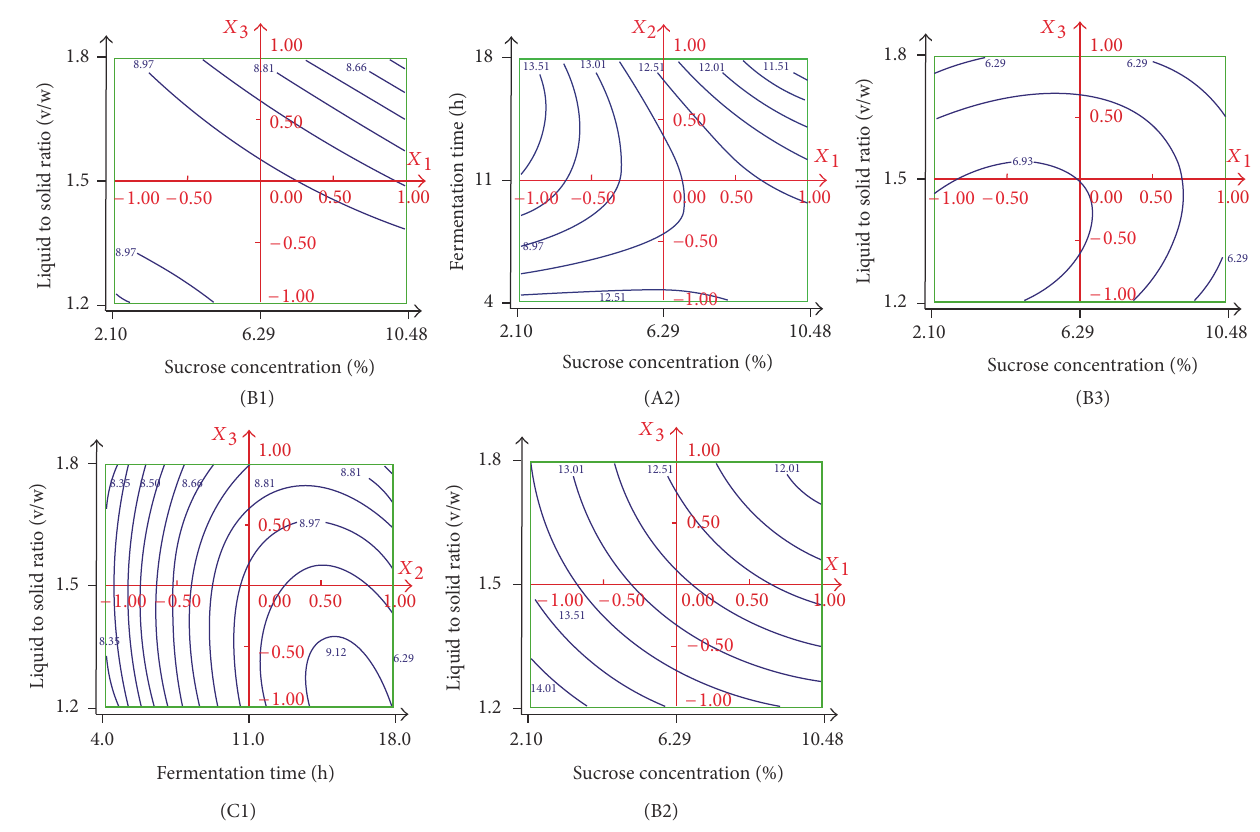
Figure 2: Responsesurface and contour plots that represent the effect of fermentation time and sucroseconcentration (A); liquid to solid ratio and sucrose concentration (B); liquid to solid ratio and fermentation time (C) and their interaction on ( 1 ) viable Lb. rhamnosus GG cells when −1 , 11h, and 1.5(vw −1 ); ( 2 ) free amino nitrogen content when 𝑋 𝑋 𝑋 𝑋 1 , 2 , and 3 are 6.29 g (100g DM) and 1.5(vw −1 ); ( 3 ) total acidity when 𝑋 1 , 𝑋 2 , and 𝑋 3 are 6.29 g (100g DM) −1 , 11h, and 1.5(vw −1 ). 𝑋 1 : sucrose concentration g (100g DM) −1 ;